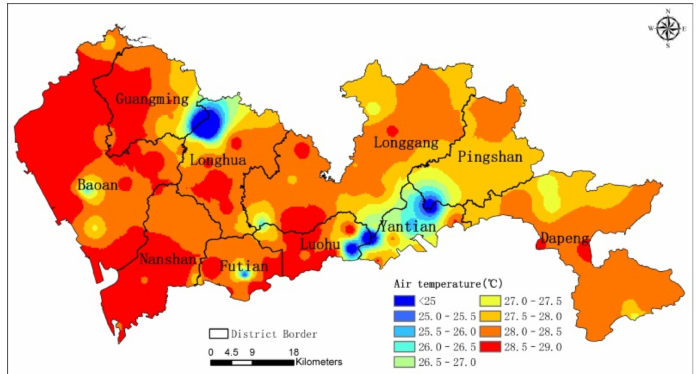
Figure 4. Spatial distribution of the average temperature in June, July, and August from 2016 to